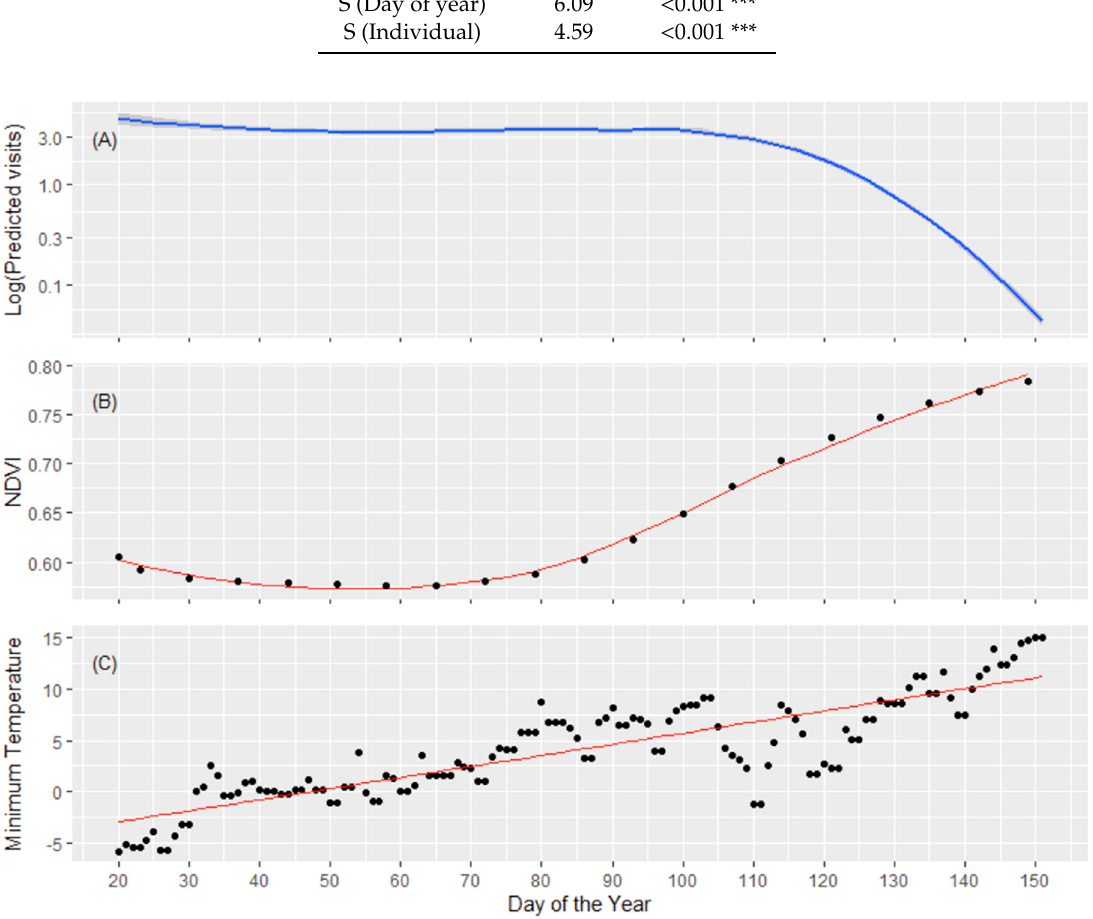
Figure 2. Predictive plot of the daily number of visits to feeding site (log scale) by roe deer as a function of the day of the year (panel A ) contrasted with the observed increment of NDVI (panel B ), and minimum daily temperature (panel C